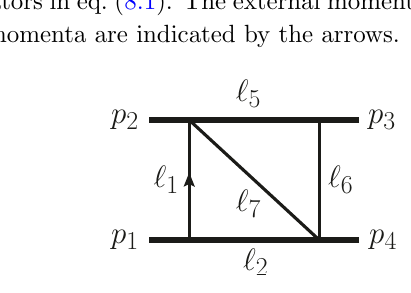
Figure 27 . The diagram H[1 ; 1 ; 0 ; 0 ; 1 ; 1 ; 1 ; 0 ; 0], with momentum assignments, obtained by cancel- ing propagators 3 and 4 of the H diagram in (cid:12)gure